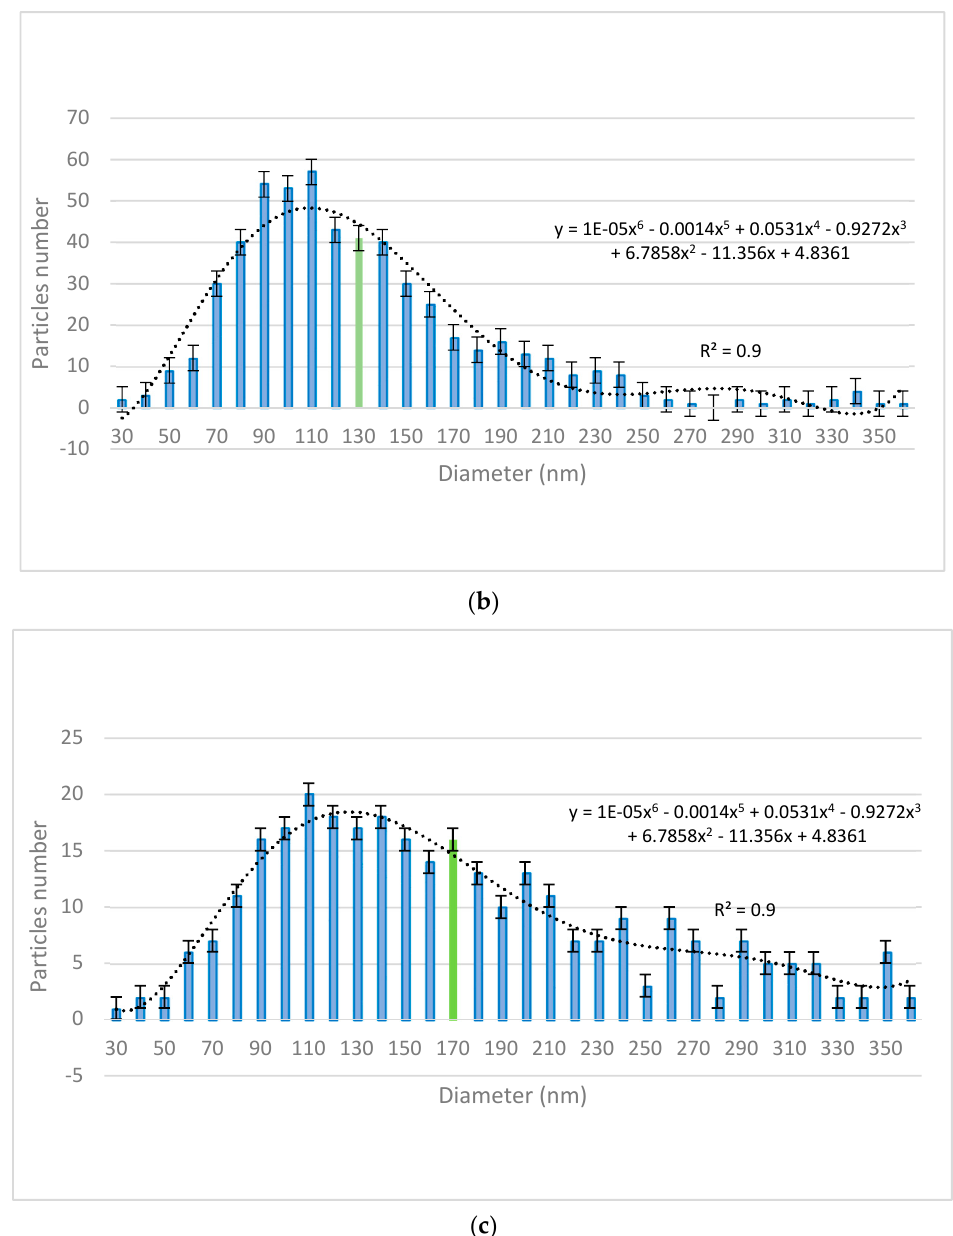
Figure 2. Size distribution of the synthesized nanoparticles: ( a ) ZnO (mean size value obtained: 134.2 nm), ( b ) TiO 2 (mean size value obtained: 131.2 nm), and ( c ) zeolite (mean size value obtained: 171.1 nm).